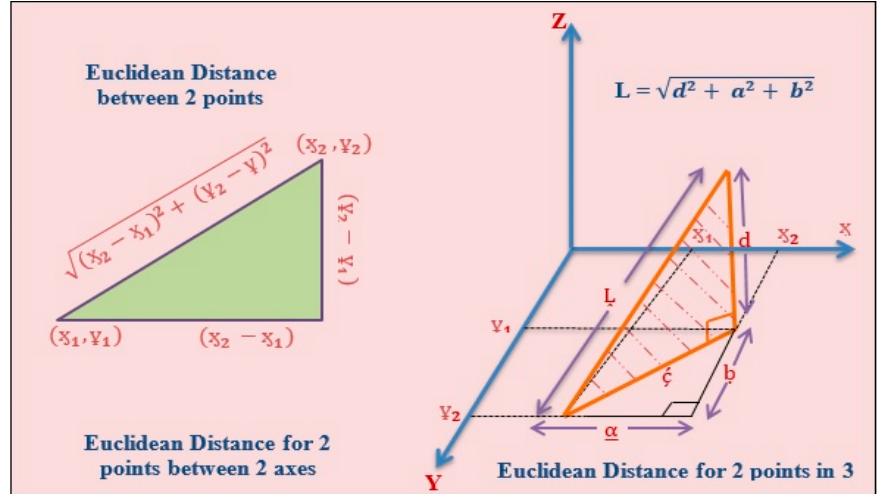
Figure 3. Euclidean distance in the order preference by similarity to ideal solution (TOPSIS) method.